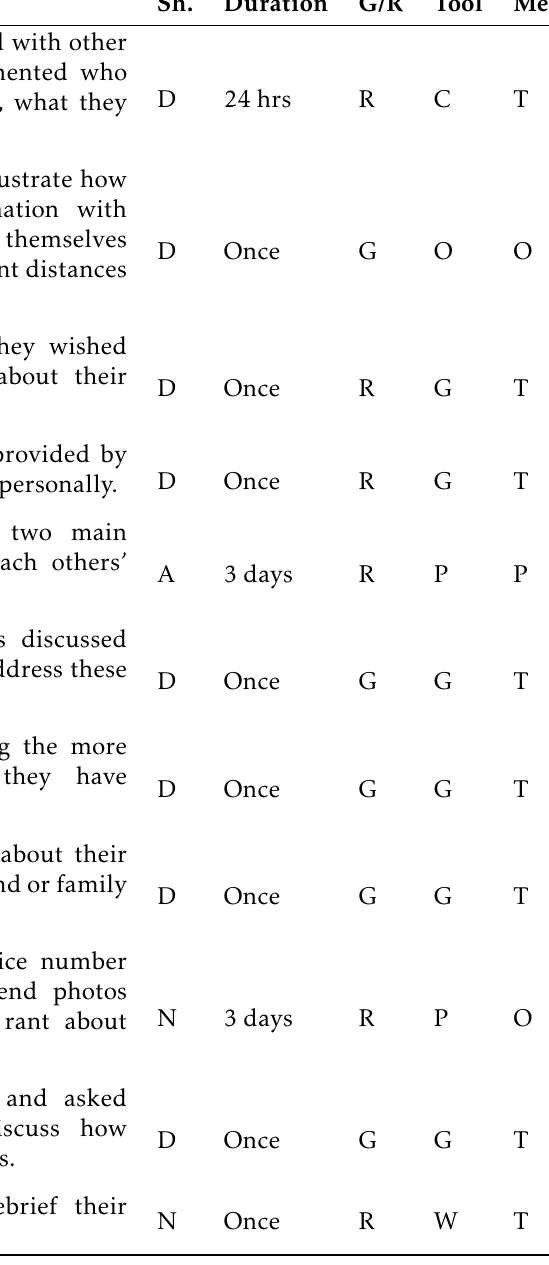
Table 1. Activitiesused in the study. Shared (Sh.): D=Responses were shared D irectly to the group. A=Responseswere collectedby researchersand A nonymizedbefore being sharedwiththe group. N=Responses were N ot sharedwiththe